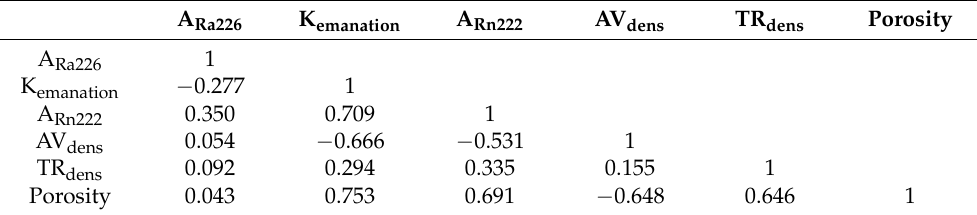
Table 4. Correlation matrix from the studied parameters of the radon